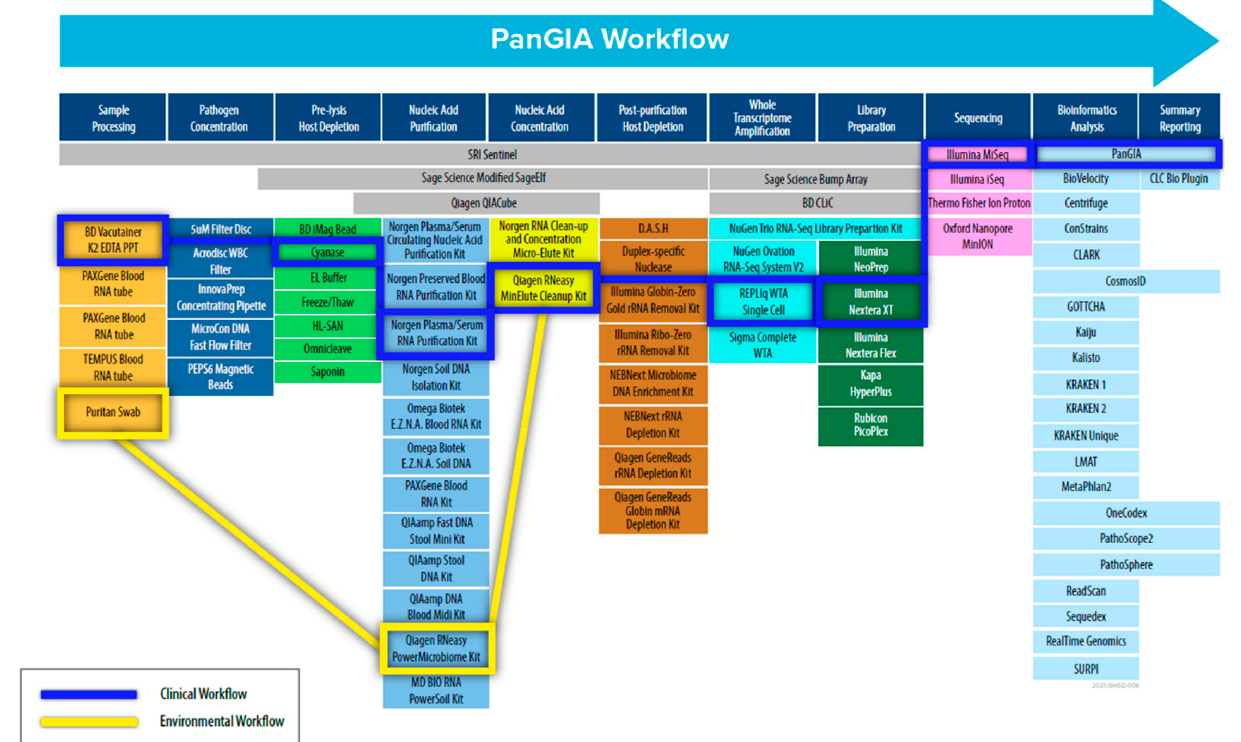
Figure 1. Schematic Diagram of the PanGIA Sample-to-Sequence Workflow. This figure outlines all the technology evaluated during the development of the Clinical and Environmental Sample-to-Sequence Workflows. The individual technologies integrated into the final PanGIA workflow are highlighted in blue for the clinical workflow and yellow for the environmental workflow. Categories that lack a selected technology were not incorporated into the final iteration of the PanGIA Workflow.